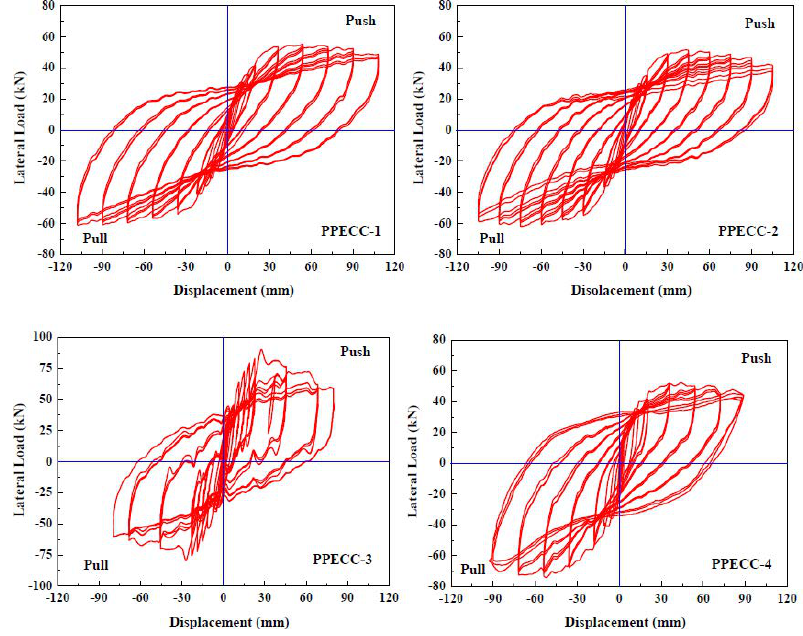
Fig. 4 Specimen load-displacement hysteresis curve